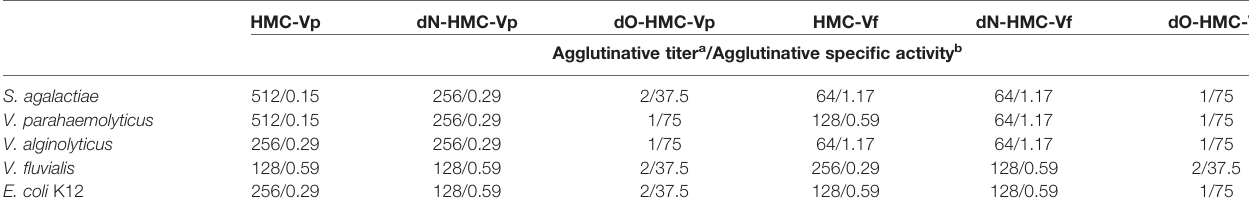
TABLE 3 | Comparison of agglutinative activity of two bacteria-binding hemocyanin and deglycosylation hemocyanin with 75 m g/ml. HMC-Vp dN-HMC-Vp dO-HMC-Vp